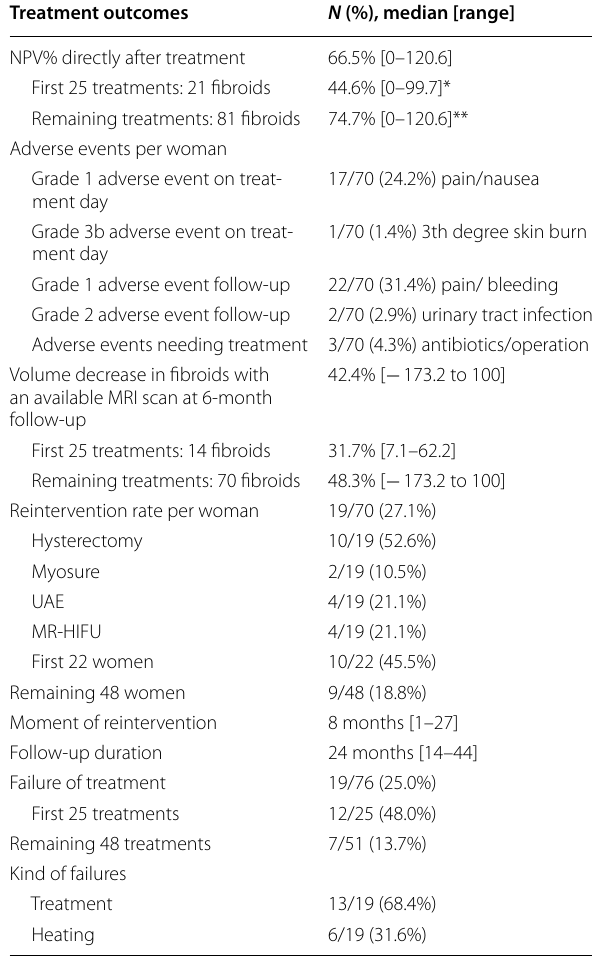
Table 3 Treatment results and follow‑up